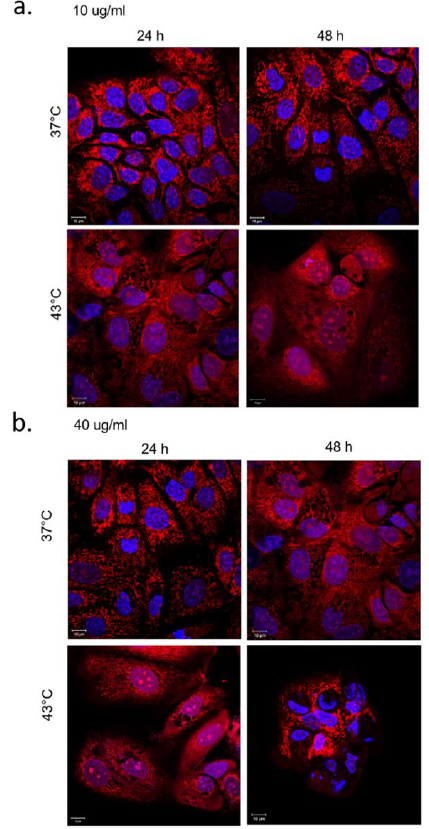
Figure 9. E ff ects of SiO 2 @LA NP S and temperature on actin network and nuclei of MCF-7 cells. MCF-7 were treated with 10 µg/mL ( a ) and 40 µg/mL ( b ) of NPs for 24 h and 48 h, fixed and then stained with Phalloidin – ATTO 488 and DAPI. The 2D images of cortical actin were acquired by a Zeiss LSM700 (Zeiss) confocal microscope equipped with an Axio Observer Z1 (Zeiss) inverted microscope using a ×100, 1.46 numerical aperture oil immersion lens. All data were processed by ZEN software (Zeiss).